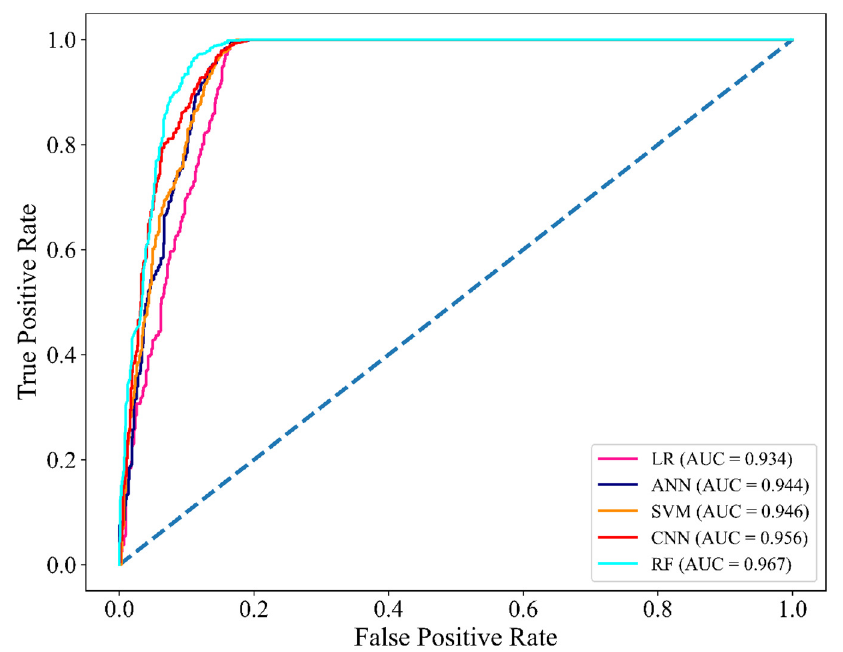
Figure 6. The ROC curves related to five employed methods using the test